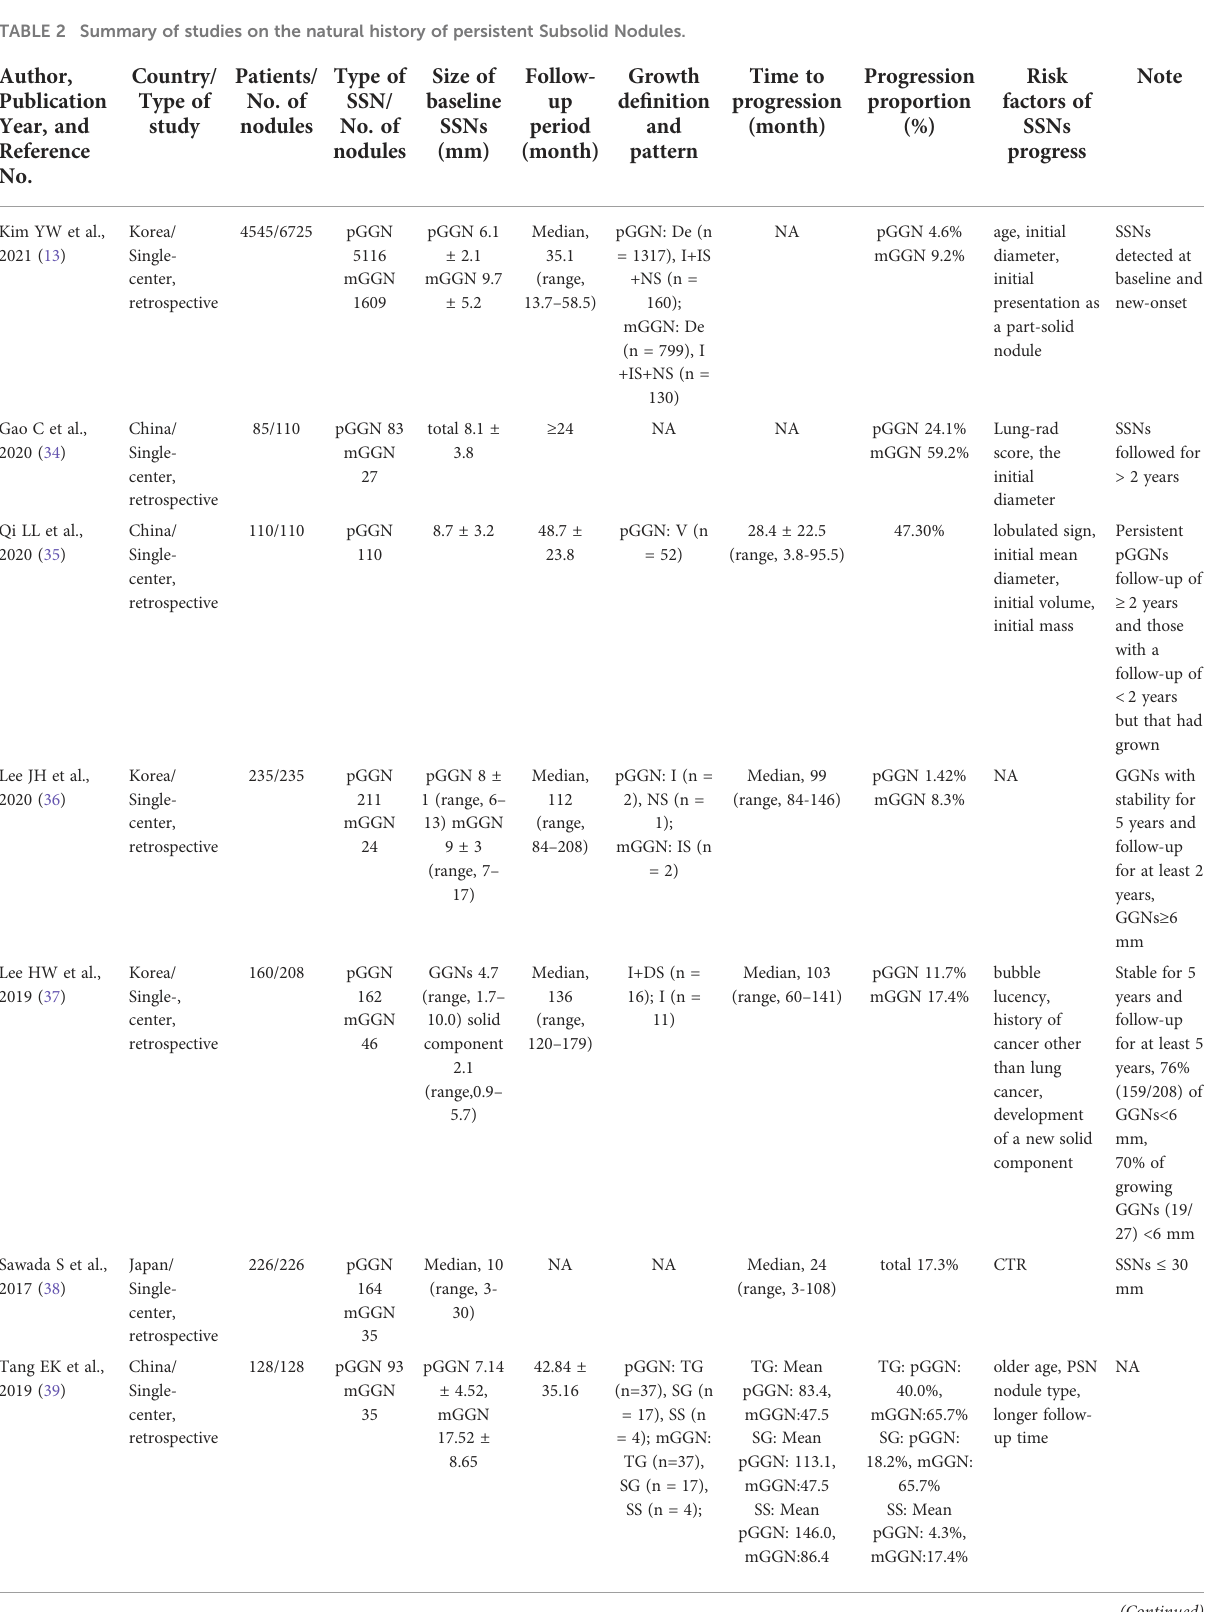
TABLE 2 Summary of studies on the natural history of persistent Subsolid